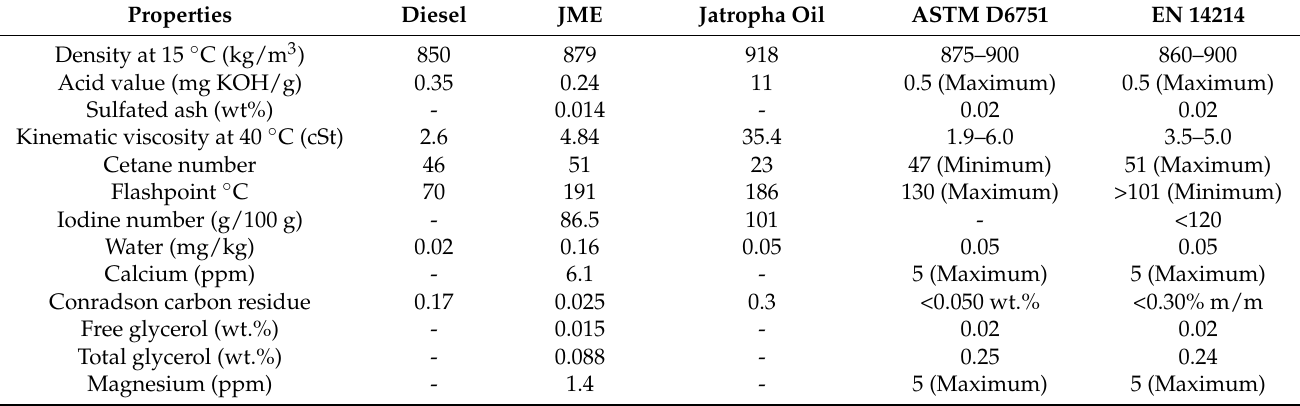
Table 6. Characteristic comparison of diesel, Jatropha methyl esters, Jatropha oil, ASTM D 6751, and EN 14214 specifications